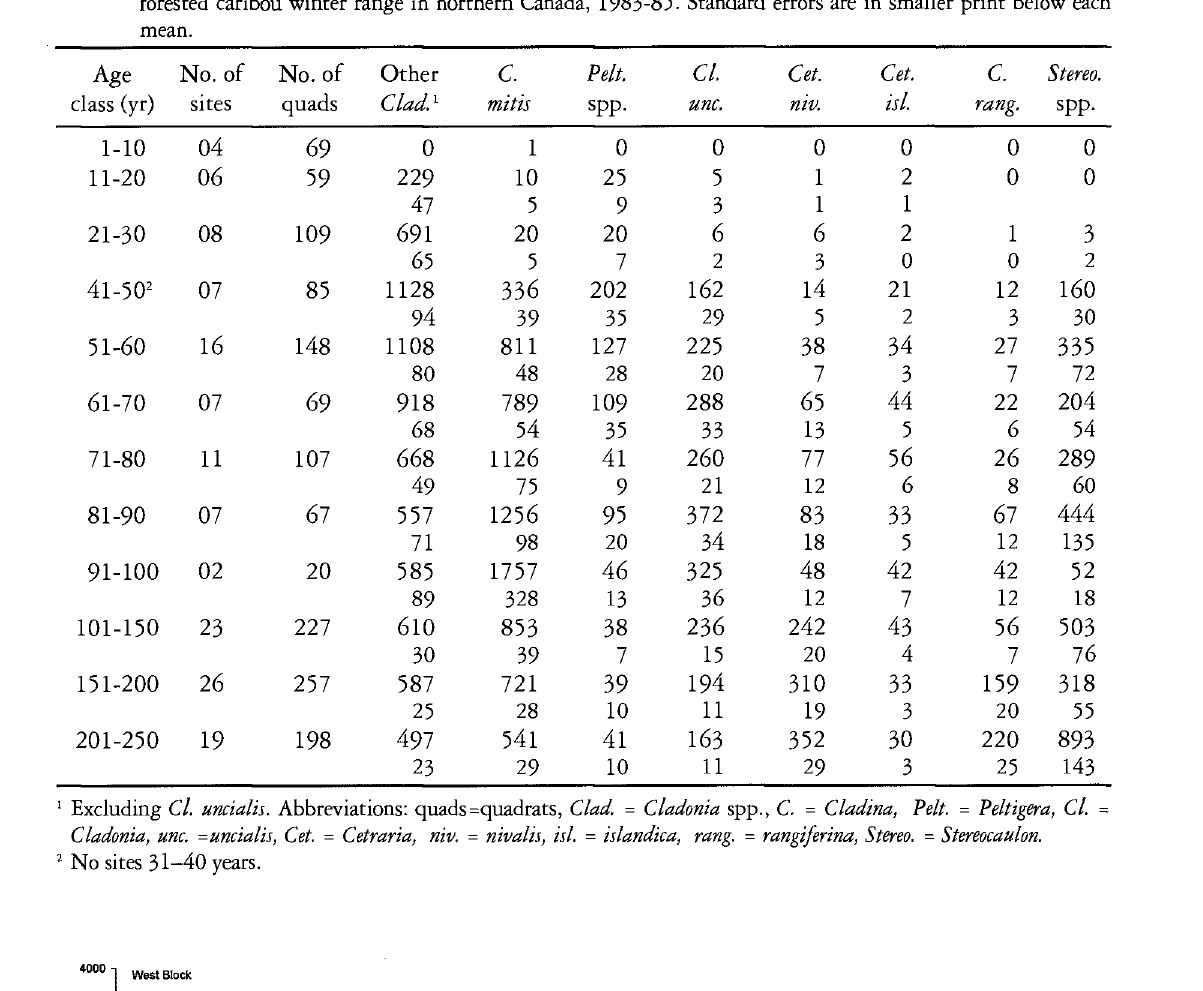
Table 1. Mean biomass (kg/ha) of lichen species in quadrats at 10- and 50-year intervals after fire in the west block of forested caribou winter range in northern Canada, 1983-85. Standard errors are in smaller print below each mean.